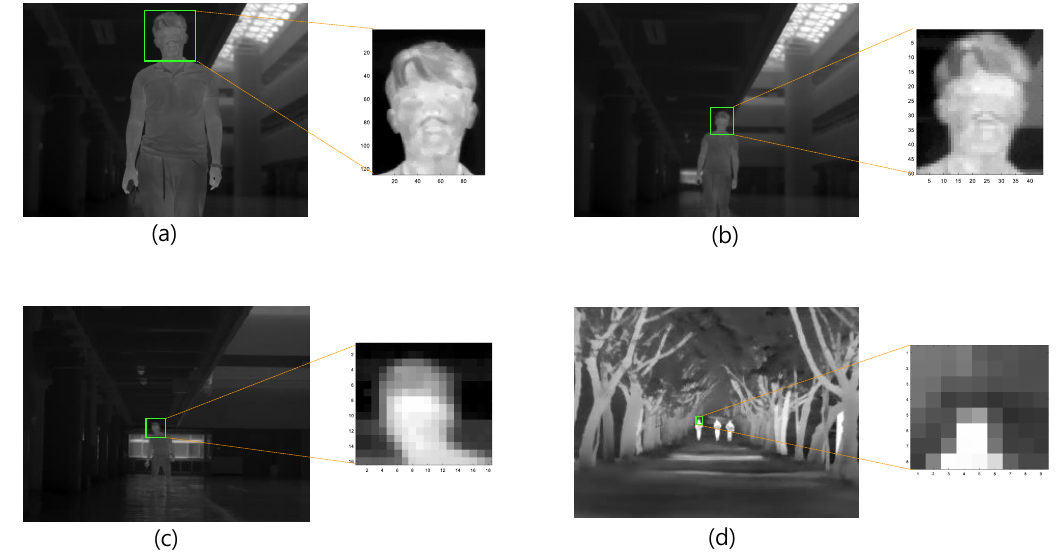
Figure 15. Tracking performance in different distances: ( a ) 5 m, ( b ) 15 m, ( c ) 35 m, ( d ) 50